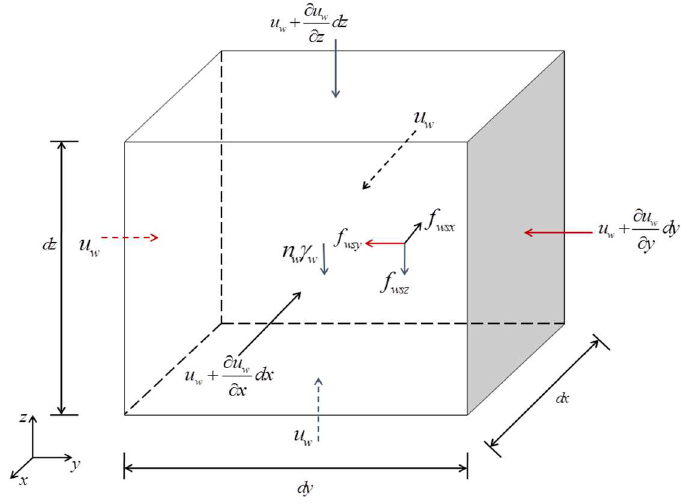
Figure 4. Equilibrium for pore-water phase of unsaturated soil.